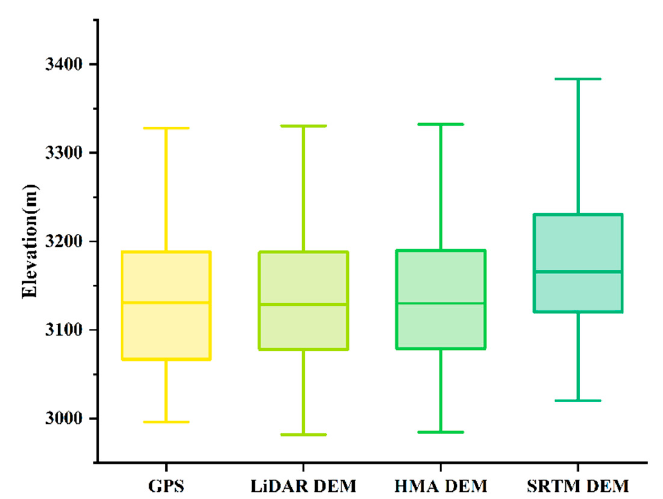
Figure 6. Difference between three kinds of DEM and GPS data.